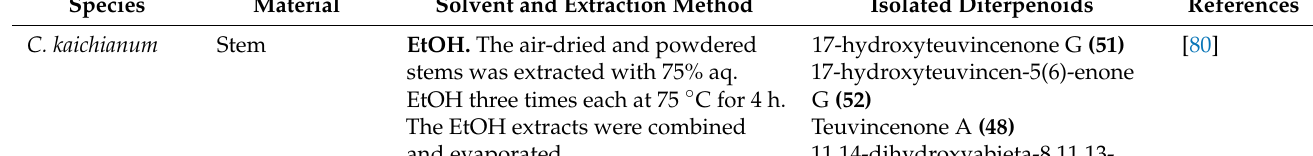
Table 7. The diterpenoid extraction method and C. kaichianum plant material for diterpenoid isolation. Species Material Solvent and Extraction Method Isolated